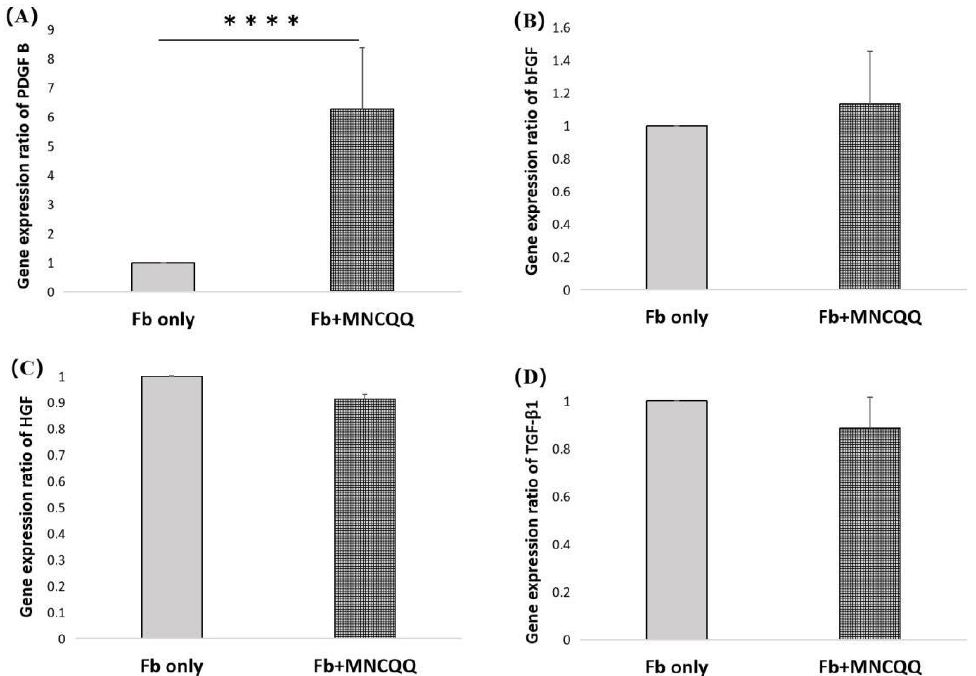
Figure 3. mRNA expression in fibroblasts under the HG condition. Reverse transcription-quantitative polymerase chain reaction for the mRNA expression levels of PDGF B ( A ), bFGF ( B ), HGF ( C ), and TGF- β 1 ( D ), respectively, in fibroblast cells in the HG condition. N = 6 volunteers. ****; vs. Fb only, p < 0.001 Fb only: fibroblasts only in high glucose; Fb + MNCQQ: fibroblasts cocultured with MNCQQ cells in high glucose.